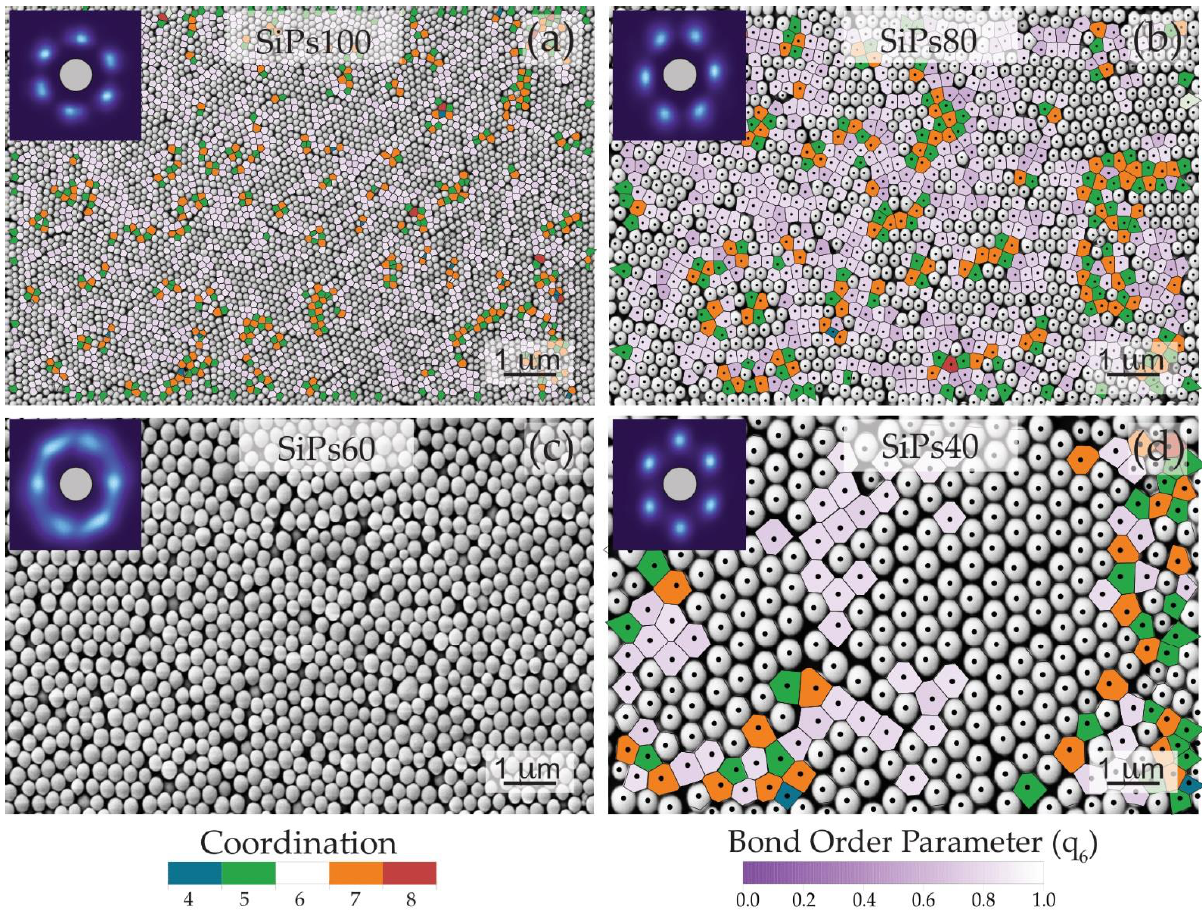
Figure 6. Overlay of Voronoi tessellation of the particle centroids over the corresponding SEM image of the particles for ( a ) SiPs100 ( b ) SiPs80 ( c ) SiPs60 and ( d ) SiPs40. Cells are colored by the number of shared facets and by the normalized bond order parameter for the type of symmetry for six neighbored cells. Whiter areas indicate particles that have high angular order in that symmetry basis. Particles with 5 and 7 neighbors typically highlight the grain boundaries and dislocation lines in their respective symmetry basis, but are not consistent with the cracks visible in the SEM images. Incorporating normalized bond order between 60% and 90% of that expected for a hexagonal lattice for 6 neighbor domains highlights the cracking observed in the films. SiPs60 in part c showed no correlations.